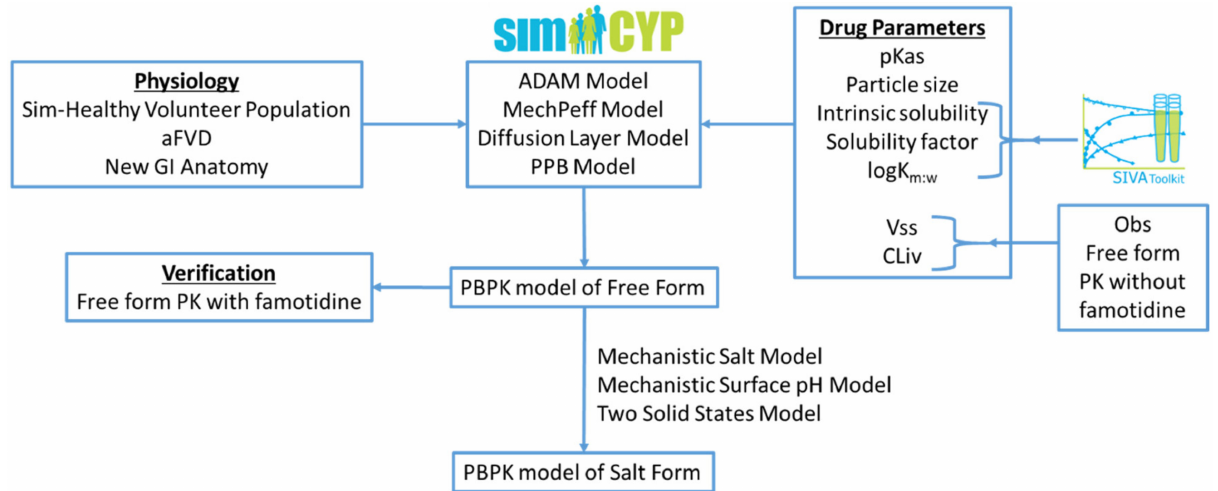
Figure 1. Modelling workflow followed within this research work: aFVD (advanced Fluid Volume Dynamics), PPB (Particle Population Balance), Vss (Volume of distribution at steady state), and CLiv (In Vivo